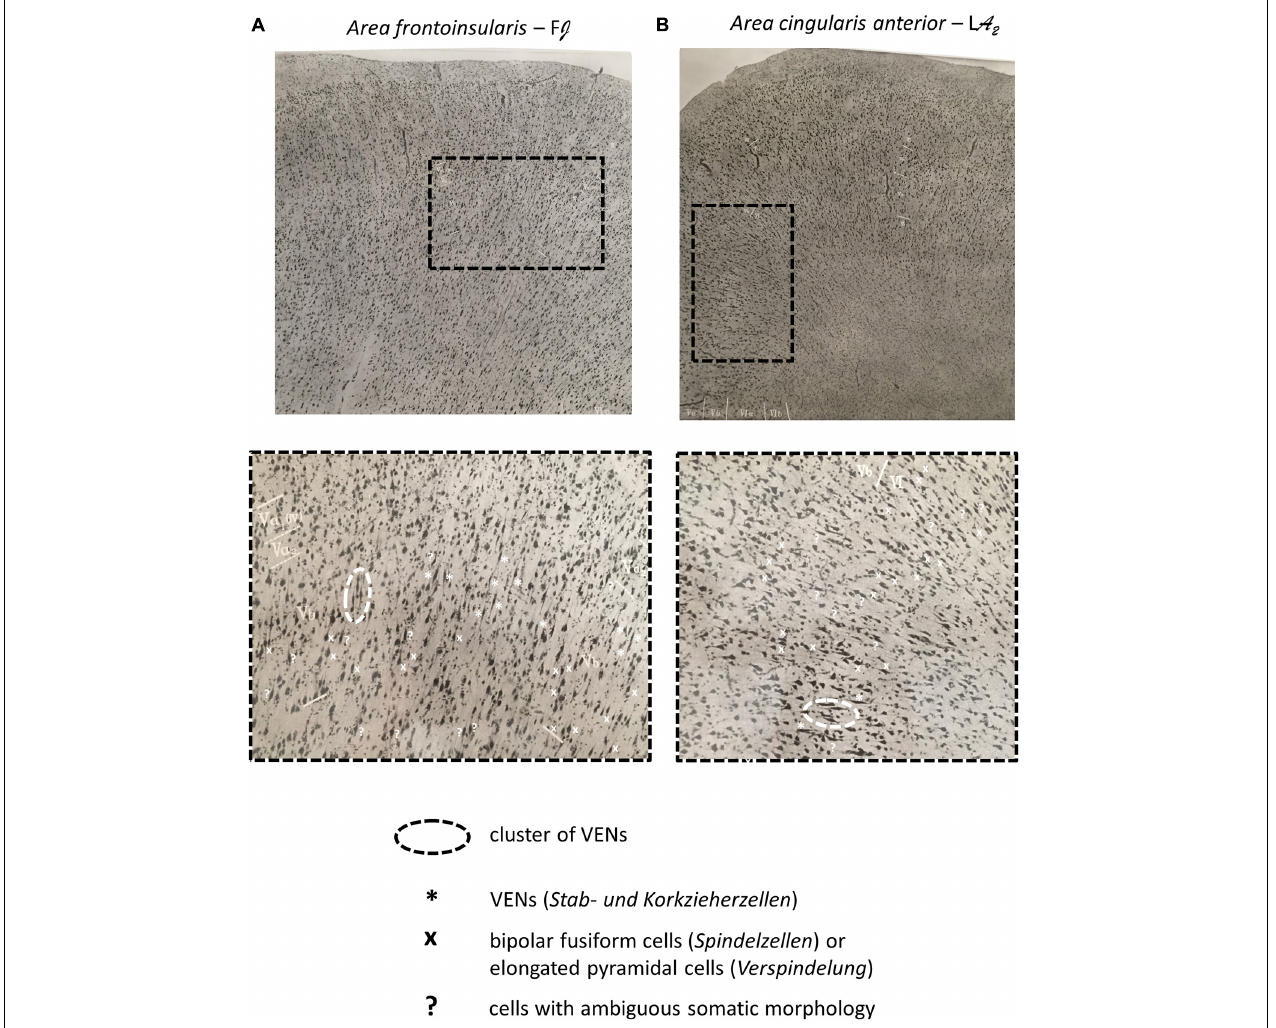
FIGURE 5 | (A) Microphotograph of the dome of the gyrus transversus insulae ( Area frontoinsularis – F J ), Nissl staining. (B) Microphotograph of the dome of the gyrus limbicus, regio anterior ; frontally and dorsally from the genu corporis callosi ( Area cingularis anterior – L A 2 ), Nissl staining. The enlarged panels show VENs in layer Vb of the FI and ACC as well as other spindle-shaped cells ( Spindelzellen ) and cells of ambiguous somatic morphology. Note that on Nissl staining, even in the FI and ACC, it is difficult to classify certain cells as either VENs or common modified pyramidal neurons (spindle cells, Spindelzellen ). Also note the clusters of VENs in both regions as well as the relative predominance of VENs in the FI compared to the ACC. Images modified from von Economo and Koskinas